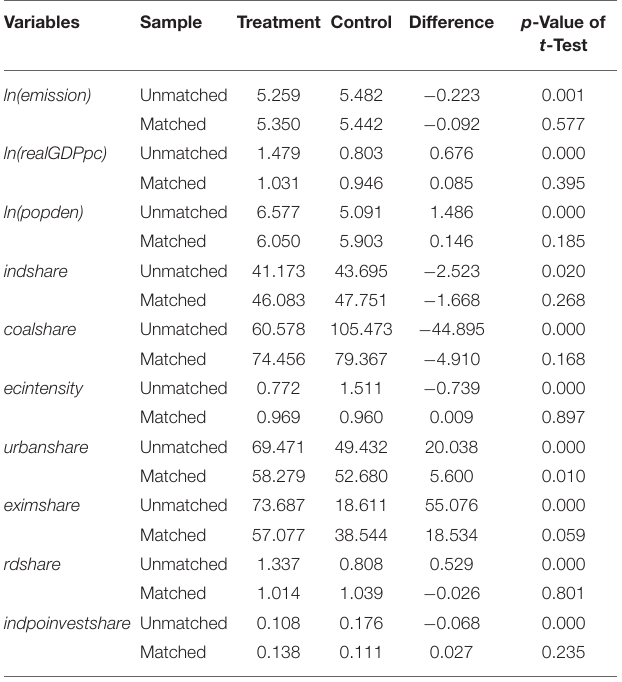
TABLE 5 | Mean of variables before and after PSM (2-NNM within radius of 0.174).